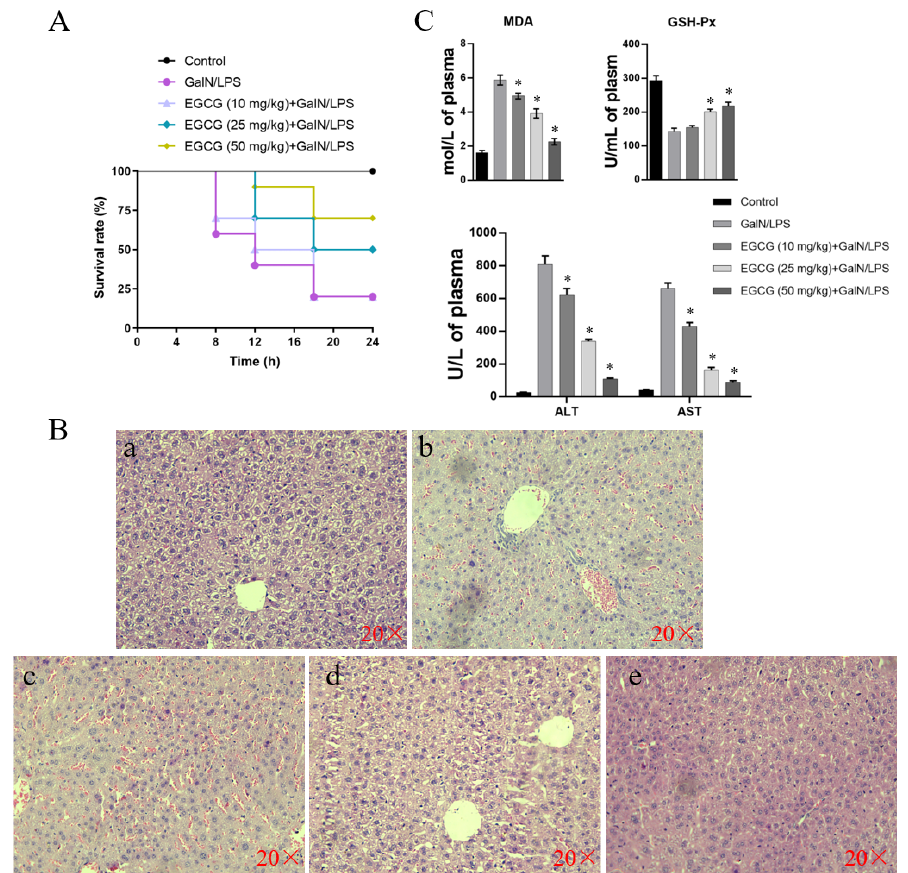
Figure 8. The effect of EGCG on the GalN/LPS-induced mortality and liver damage in mice. ( A ) Mortality of mice administrated with EGCG followed by GalN/LPS challenge. Mice were intraperitoneally injected with GalN/LPS, with oral administration of EGCG at (10, 25, and 50 mg/kg) for 10 days before GalN/LPS injection. ( B ) H&E staining of the liver after GalN/LPS injection. Images from each experimental group were original magnification of × 400. ( a ) Control group; ( b ) mice treated with GalN/LPS; ( c – e ) EGCG treated (10, 25, and 50 mg/kg) followed by GalN/LPS injection. ( C ) Plasma levels of MDA, GSH-PX, and ALT and AST in all groups of mice. * p < 0.05 vs. the GalN/LPS group. Results are expressed as means ± S.E.M.